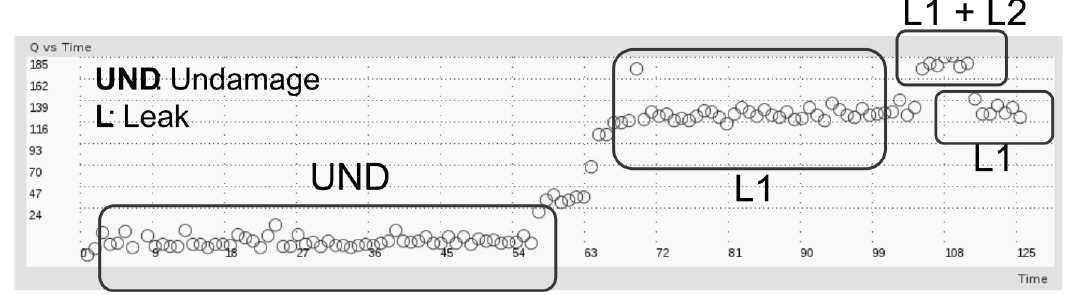
Figure 15. Leak detection in the loop